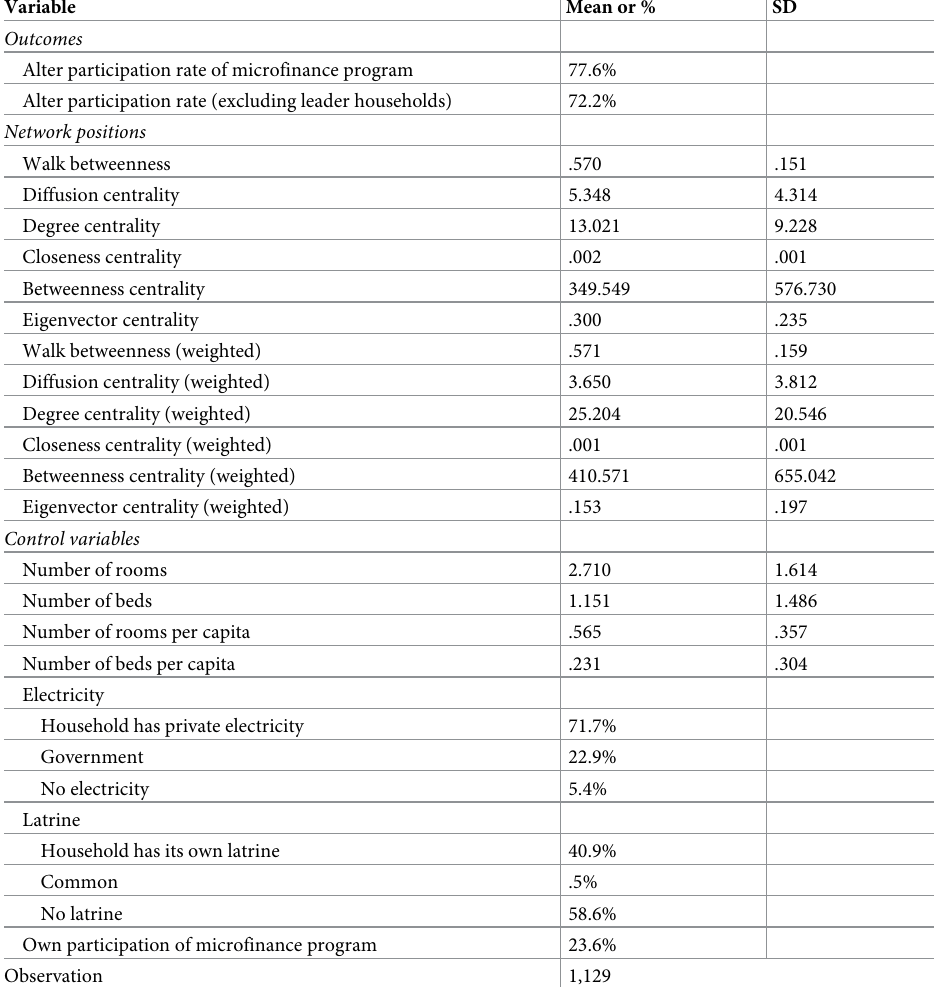
Table 3. Descriptive statistics of leader households’ walk-betweenness and other